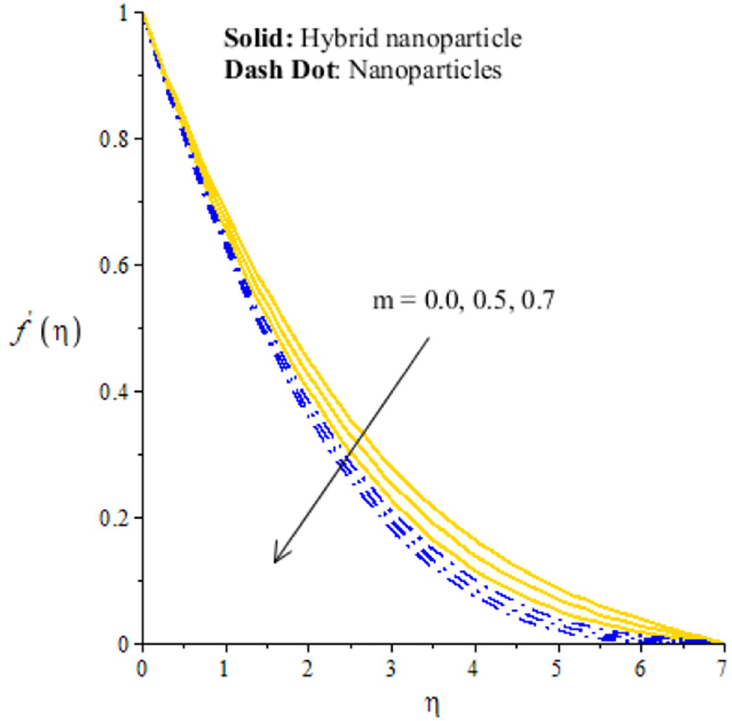
Fig 4. Distribution of velocity versus m .